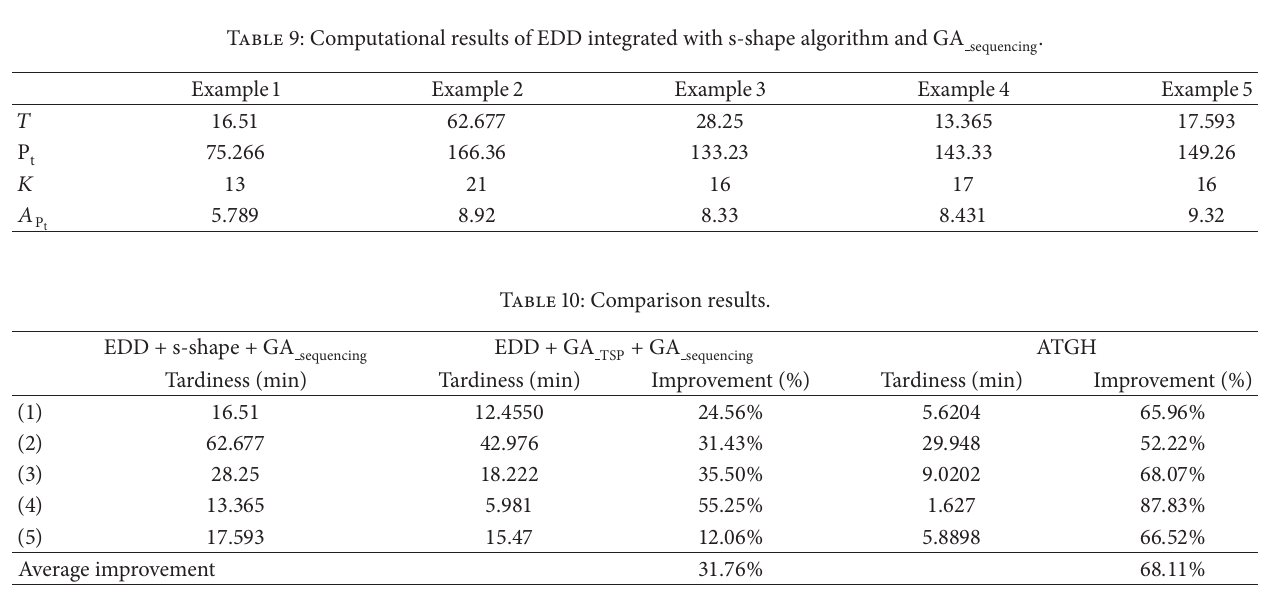
Table 9: Computational results of EDD integrated with s-shape algorithm and GA